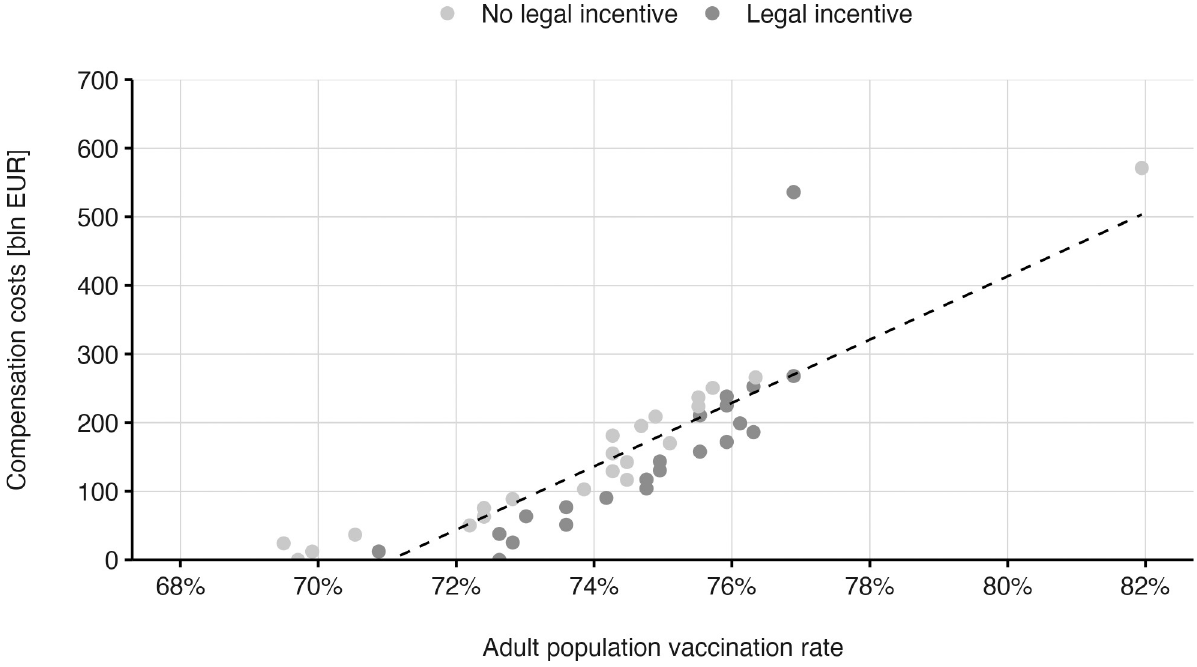
Fig 2. Economic costs associated with realizing specific vaccination uptake rates for the adult population in Germany. The visualization assumes that individuals 75 years and older will make decisions similar to the younger adults examined in our study. The dotted line denotes a linear fit after collapsing the legal incentive